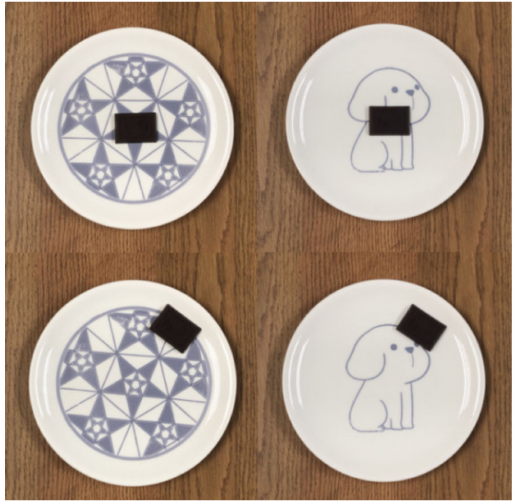
Figure 4. Example of a beautiful classical aesthetic pattern plate ( left ) and a beautiful expressive aesthetic pattern plate ( right ) with the chocolate at the center ( top ) and edge ( bottom